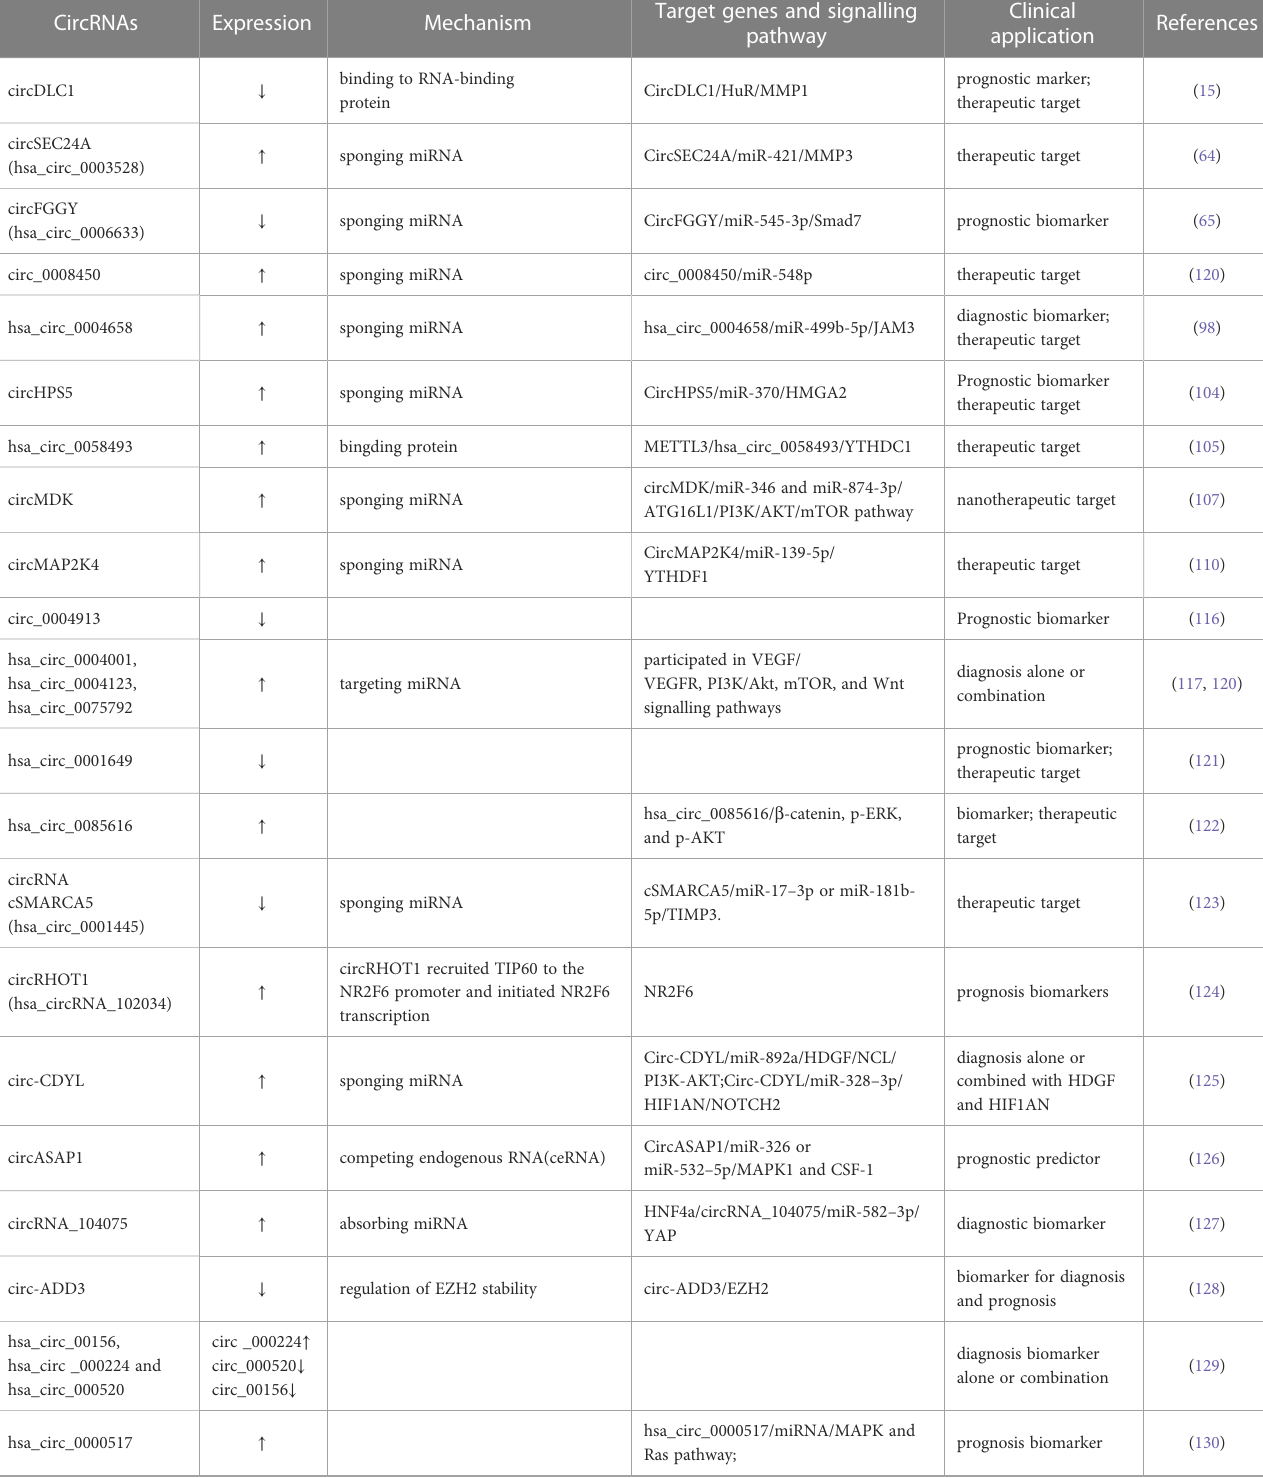
TABLE 2 Expression, functional characterization and clinical application of circRNAs in